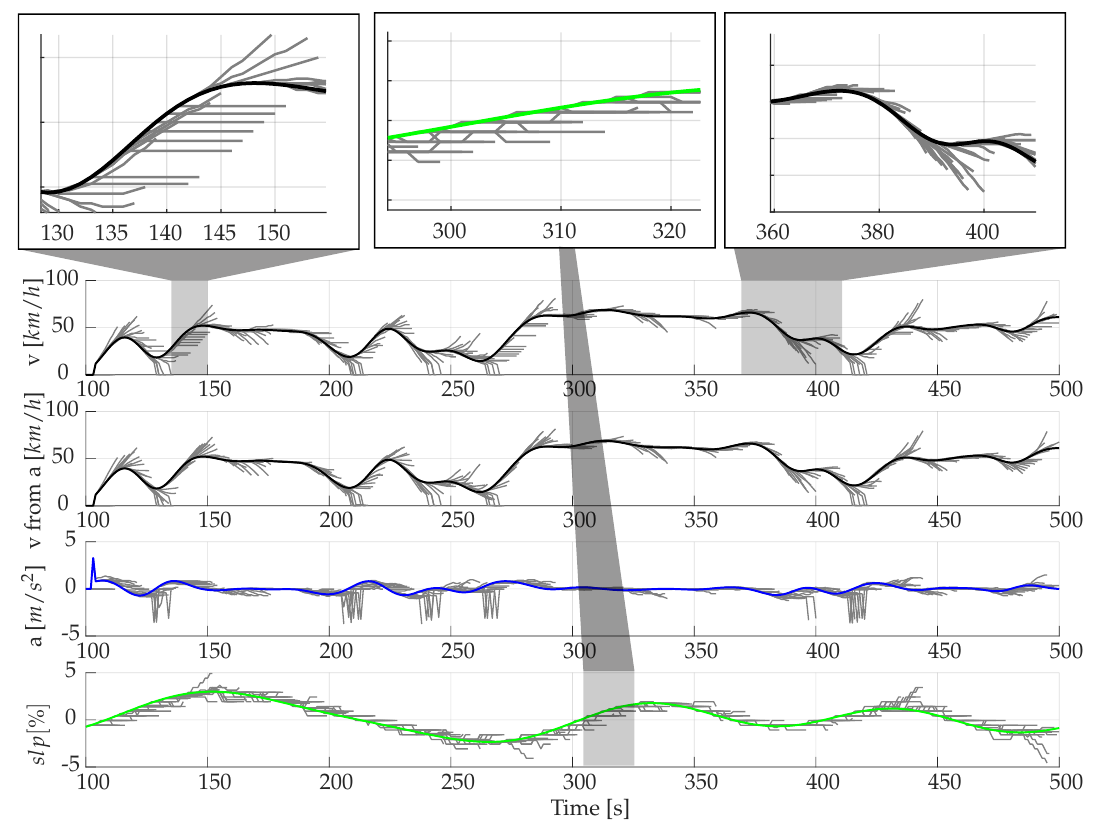
Figure 10. Predictions using MC including slope [Driver 1 /10 s prediction